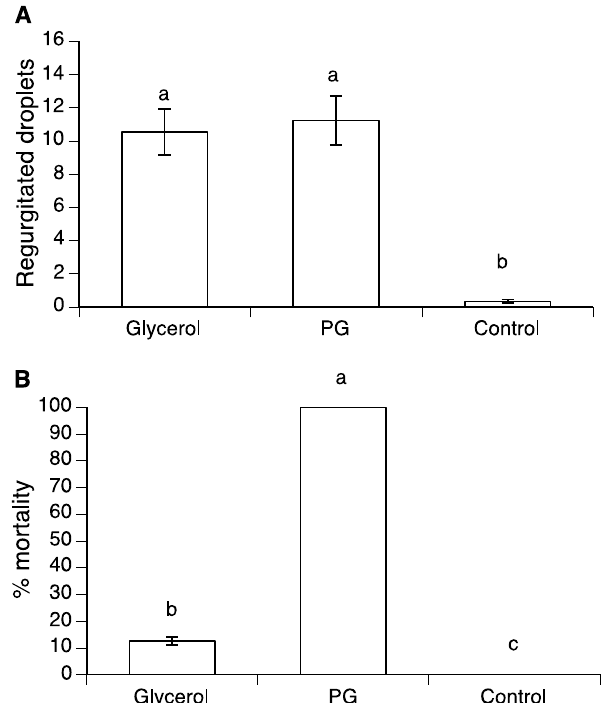
Figure 4. ( A ) Mean ( ± SE) regurgitated droplets deposited on cup walls by D. suzukii flies exposed to 4.18 M PG and 4.18 M glycerol solutions. ( B ) Percentage of dead flies at 72 h after treatment with 50% concentrations of PG and glycerol. Control flies consumed 50% sucrose solution. Columns headed by the same letter are not significantly different (GLM post-hoc contrasts, at the p = 0.05 level).